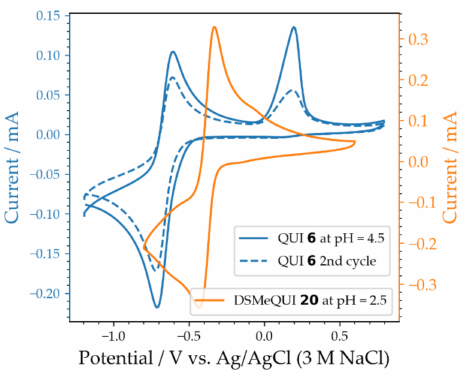
Figure 9. Cyclic voltammetry of 5 mM QUI 6 (blues) and 5 mM DSMeQUI 20 (orange) solutions in Britton–Robinson buffer adjusted to pH 4.5 and pH = 2.5, respectively. The voltammograms were recorded at a scan rate of 100 mV/s using a 3 mm diameter glassy carbon disk